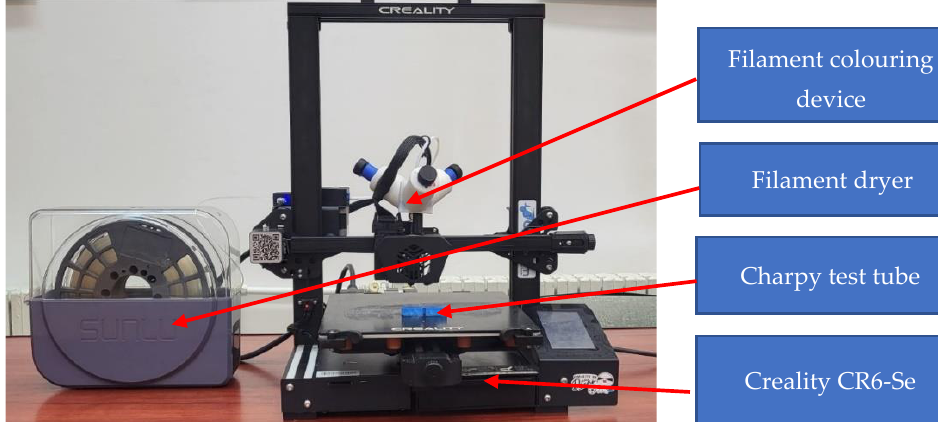
Figure 5. Fabrication setup.